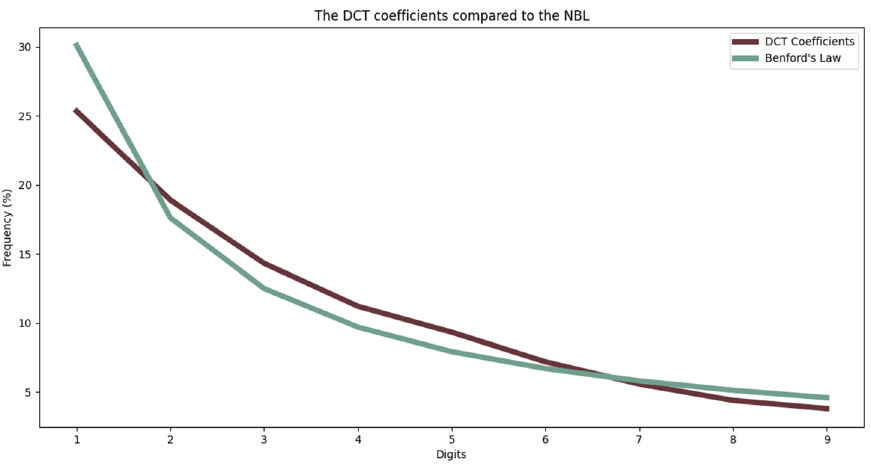
Figure 12. The DCT coefficients compared to the NBL for an image originally compressed with QF = 50.